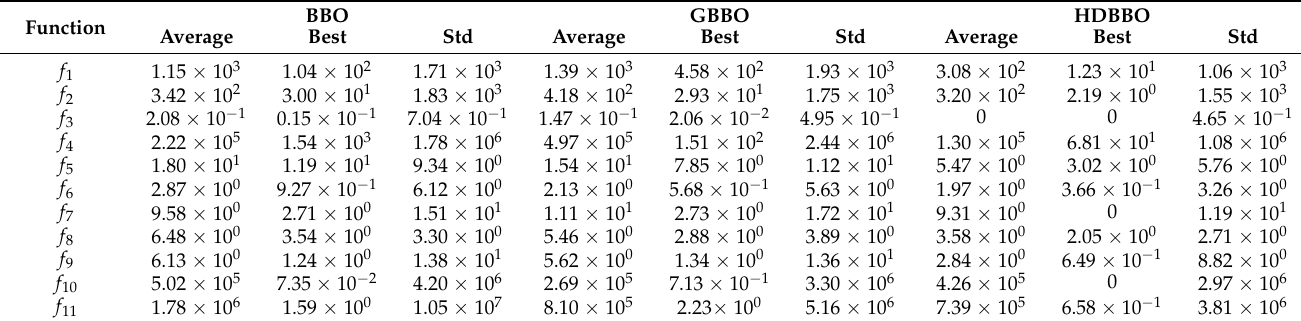
Table 3. Simulation data of three algorithms on 11 benchmark